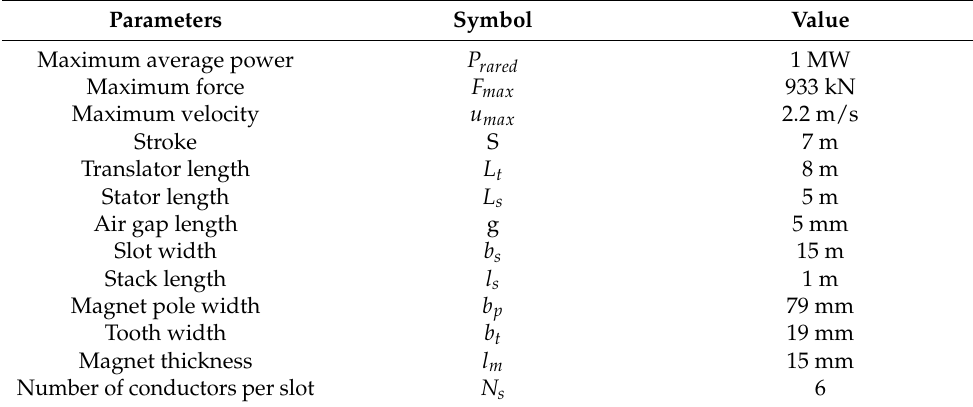
Table 2. Design parameters of the reference linear